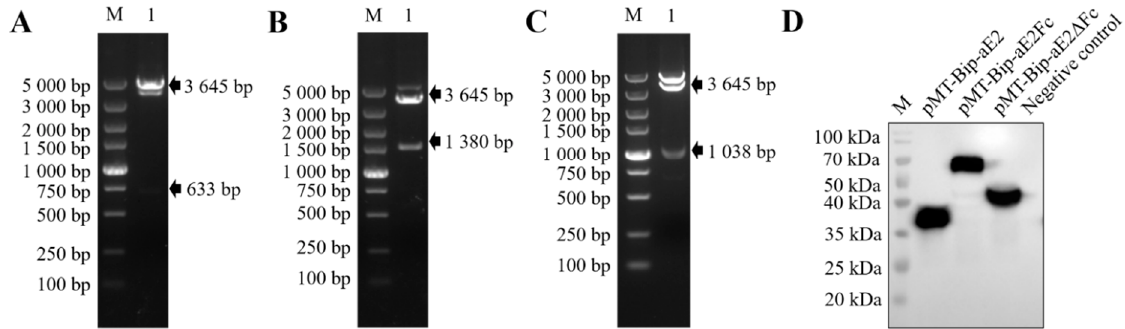
Figure 1. Identification of the recombinant Drosophila cell lines. The recombinant plasmids pMT-Bip-aE2 ( A ), pMT-Bip-aE2Fc ( B ), and pMT-Bip-aE2 Δ Fc ( C ) were digested with EcoR I and Xho I and analyzed via 1% agarose gel electrophoresis. M, DL 5000 DNA Marker. ( D ) Western blotting analysis of APPV E2, E2Fc, and E2 Δ Fc proteins expressed in S2 cells. The pMT-Bip-V5-HisA vector was used as a negative control. The S2 cell lines, which stably express APPV E2, E2Fc, and E2 Δ Fc proteins, were induced by CuSO 4 and cultured at 27 °C for 4 days. M, protein marker.